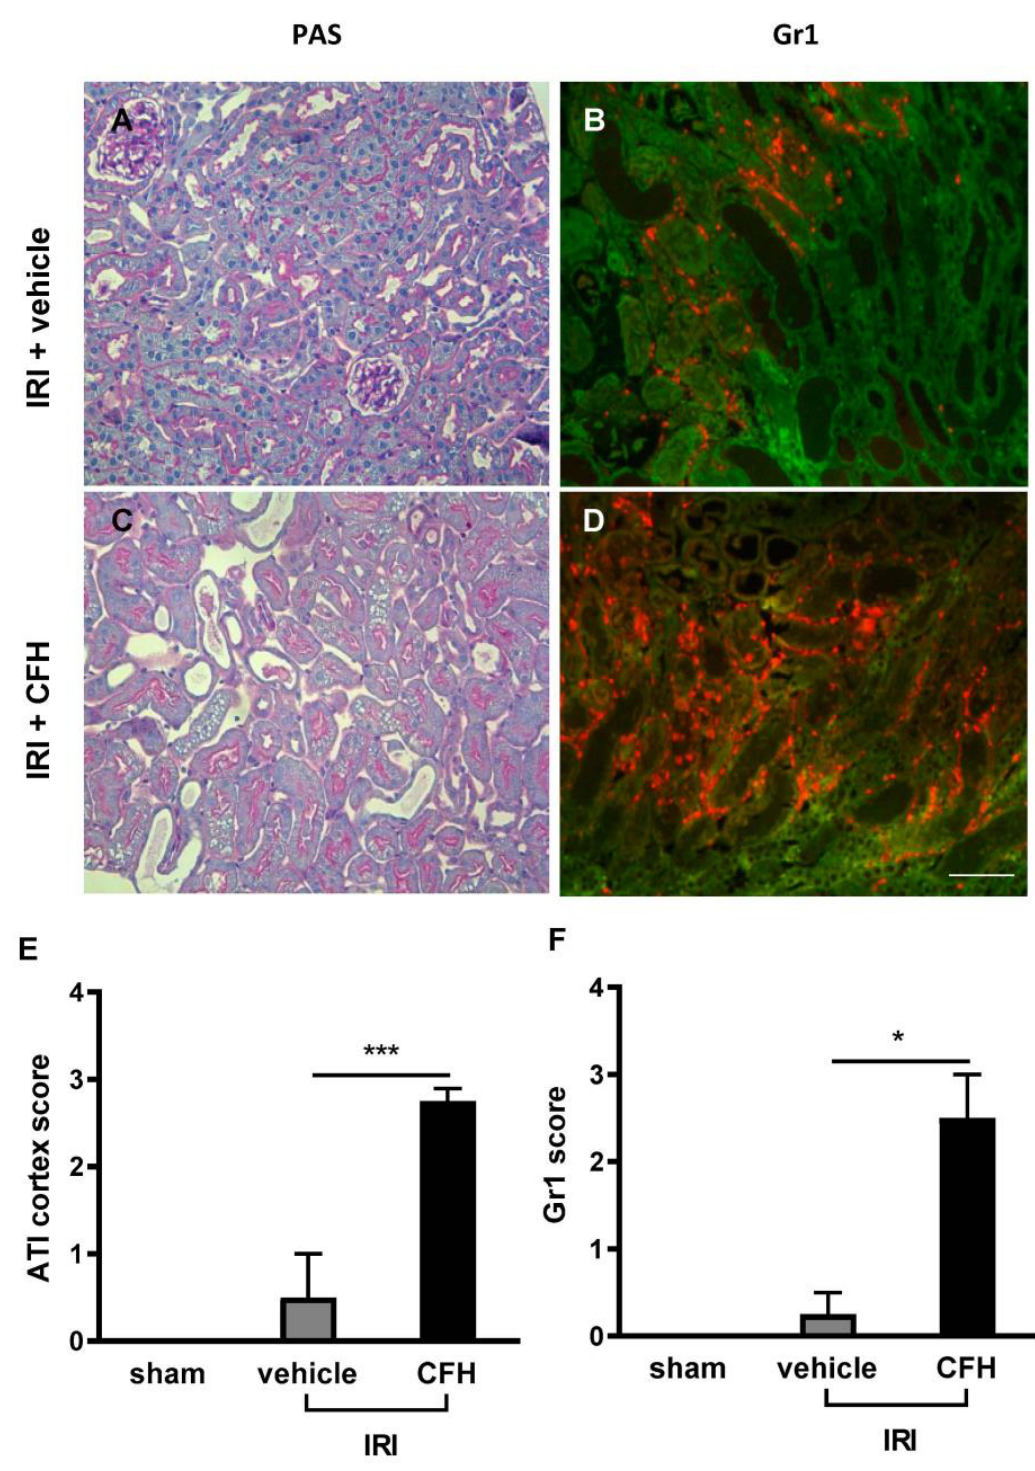
Figure 5. Renal morphology (PAS staining, ( A , C )) and neutrophil infiltration (immunofluorescence for Gr-1 ( B , D )) in mice 48 h after IRI with and without CFH treatment. The renal IRI model used in this study was characterized by only minor morphological kidney damage ( A , E ). However, CFH administration in renal IRI mice caused severe acute tubular injury (ATI) with loss of brush border, tubular dilatation, and tubular cast formation ( C , E ). After renal IRI and vehicle treatment, minor renal neutrophil infiltration was observed ( B , F ). In contrast, severe neutrophil infiltration was present 48 h after IRI and CFH treatment ( D , F ). * p < 0.05, *** p < 0.001. Scale bar 100 µ